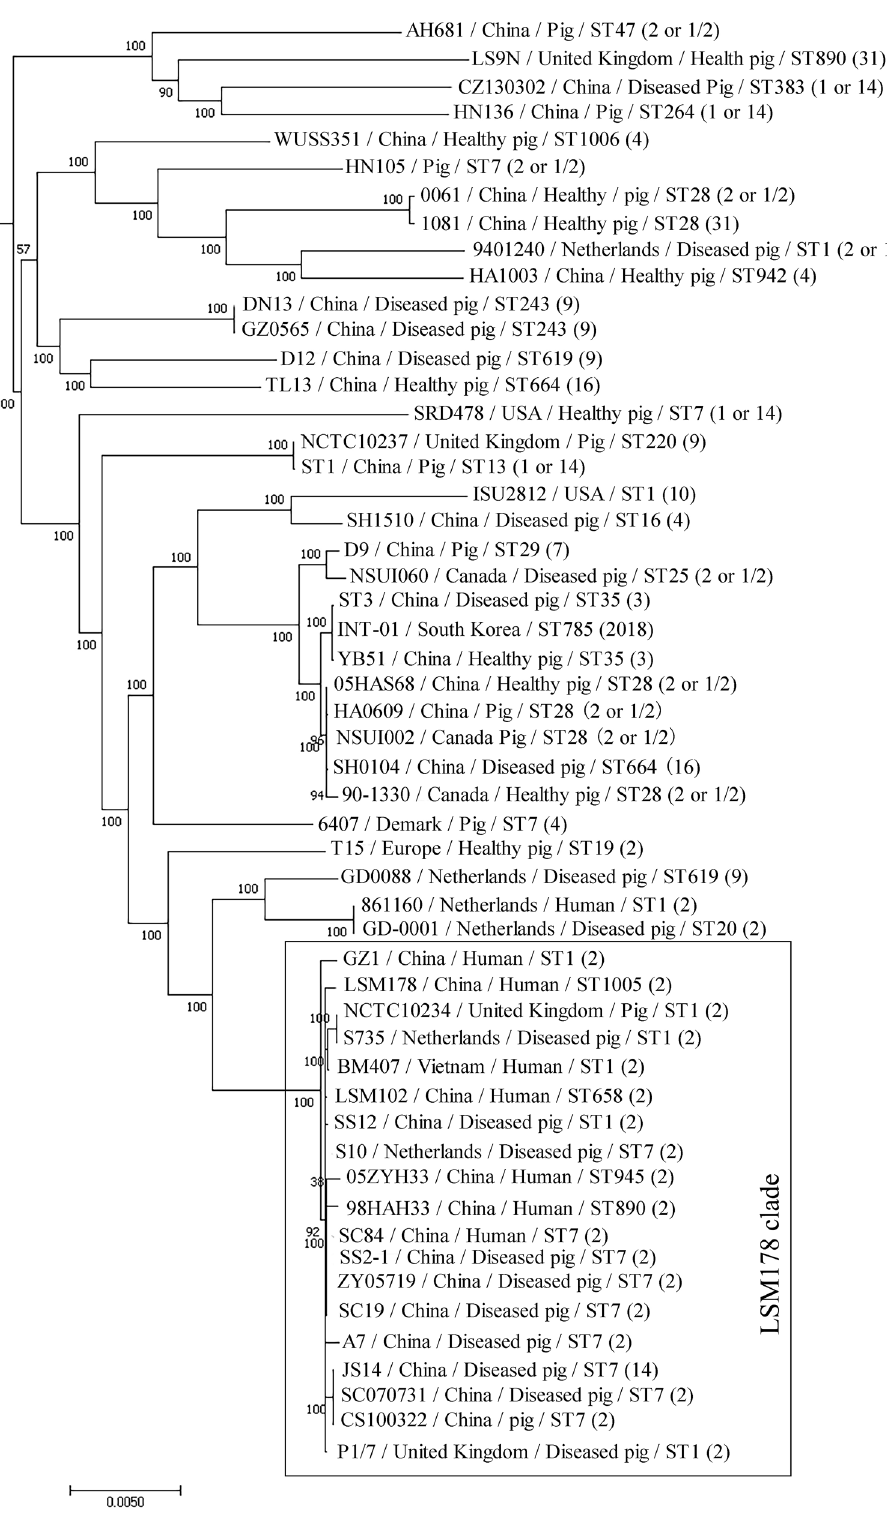
Figure 4. Phylogenetic tree of 53 S. suis based on core genome SNP. The image was generated by FastTree embedded in the Parsnp v1.1.2 and online website iTOL (http:// itol. embl.